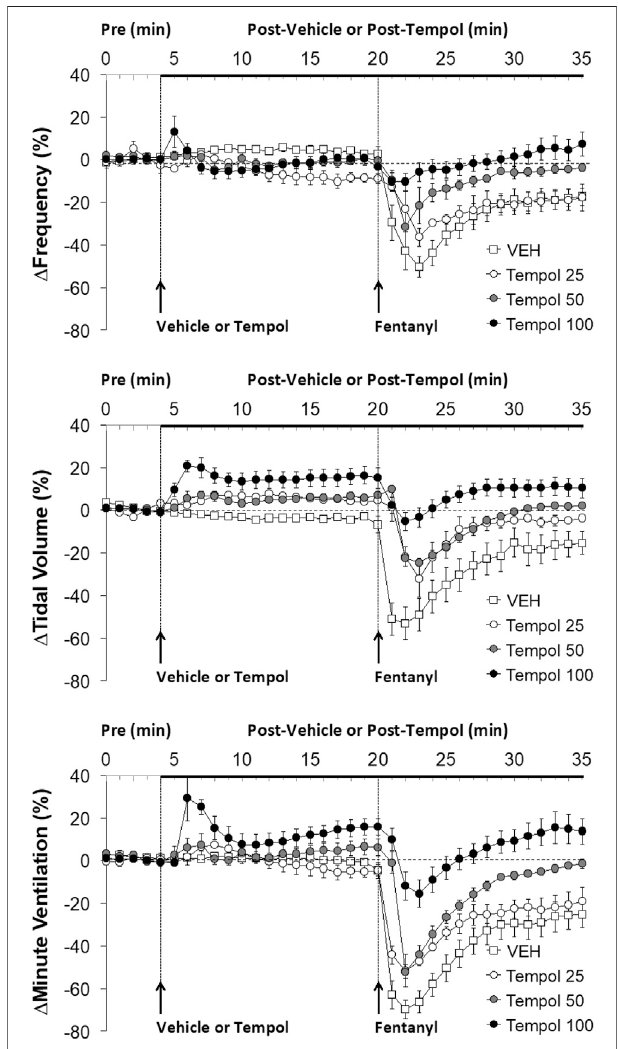
FIGURE 1 | The changes in ventilatory parameters elicited by bolus injections of vehicle (VEH) or Tempol (25, 50 or 100 mg/kg, IV) and subsequent injections of fentanyl (5 μ g/kg, IV) in iso fl urane-anesthetized rats. Therewere12ratsinthevehiclegroup,and3,5and12ratsinthe25,50 and 100 mg/kg Tempol groups, respectively. The data presented are mean ±